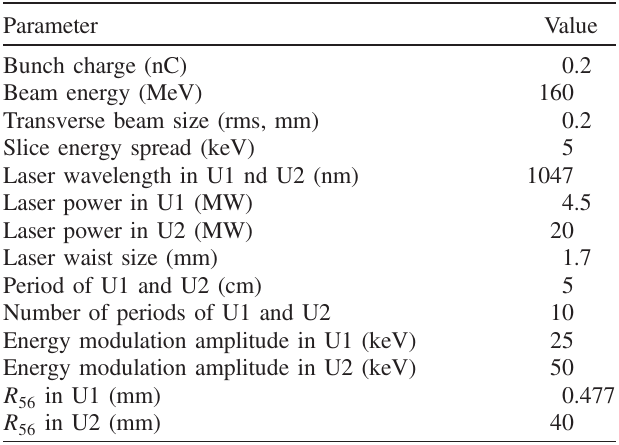
TABLE I. Main parameters in the ELEGANT simulation.